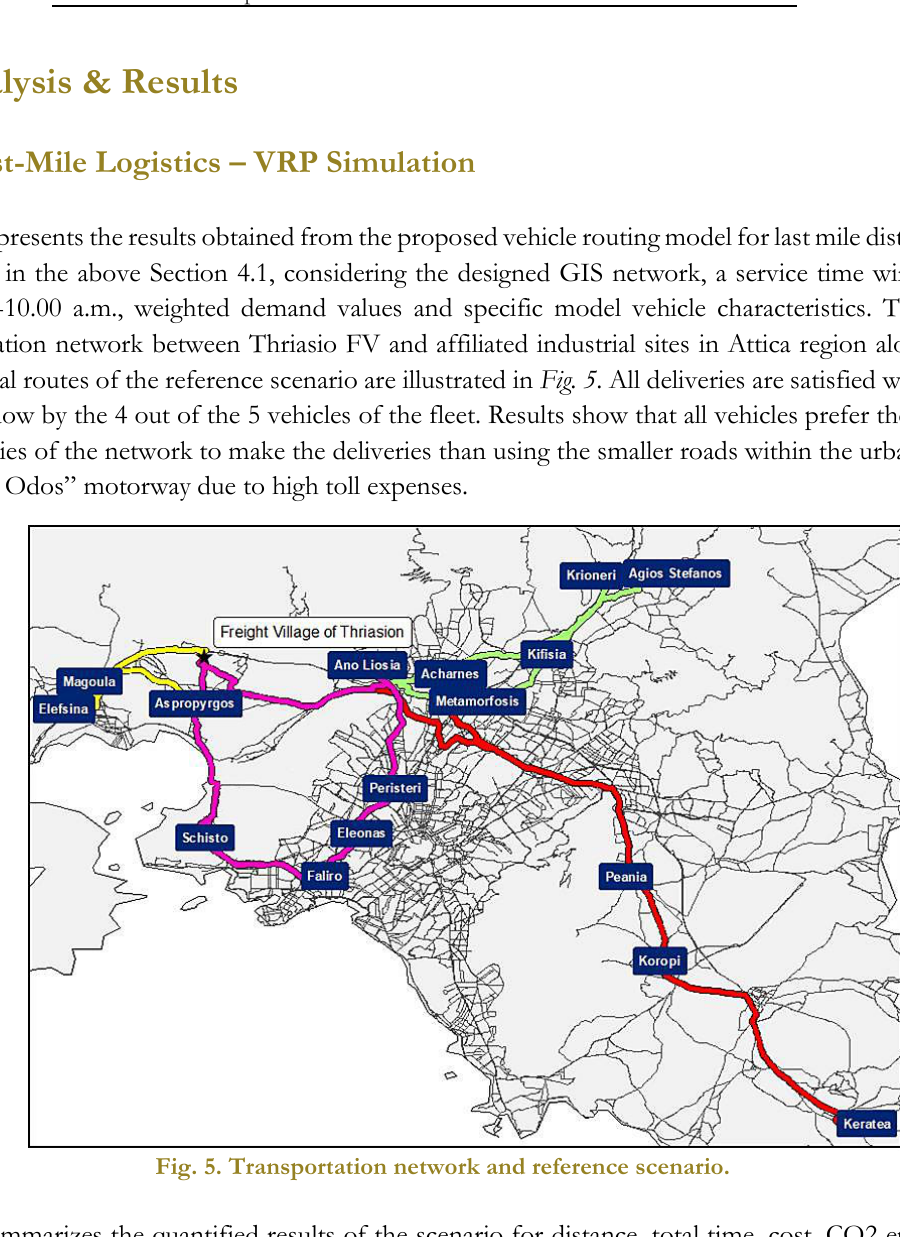
Table 4. Last-mile indicators.